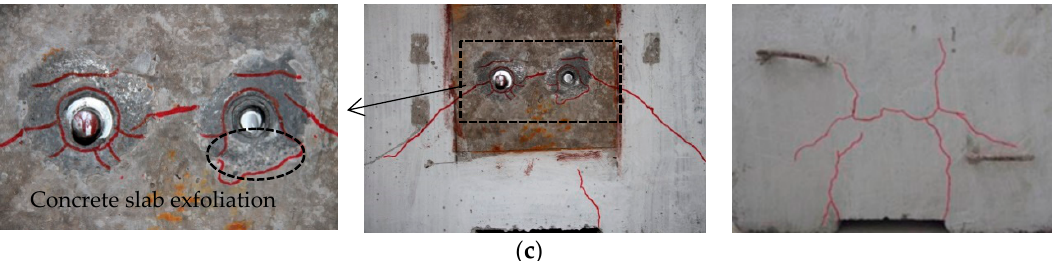
Figure 5. Failure modes: ( a ) 10 mm bolt and concrete slab (T1-10-01); ( b ) 12 mm bolt and concrete slab (T4-7012-02); ( c ) 16 mm bolt and concrete slab (T5-5016-01).